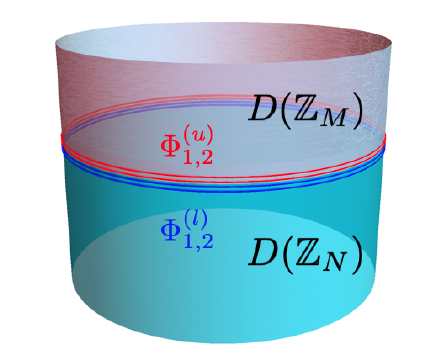
Figure 1. The D ( Z N ) (cid:0) D ( Z M ) interface on a cylinder. The doubled red and blue lines at the interface denotes the pair of left and right moving modes in the upper and lower entanglement